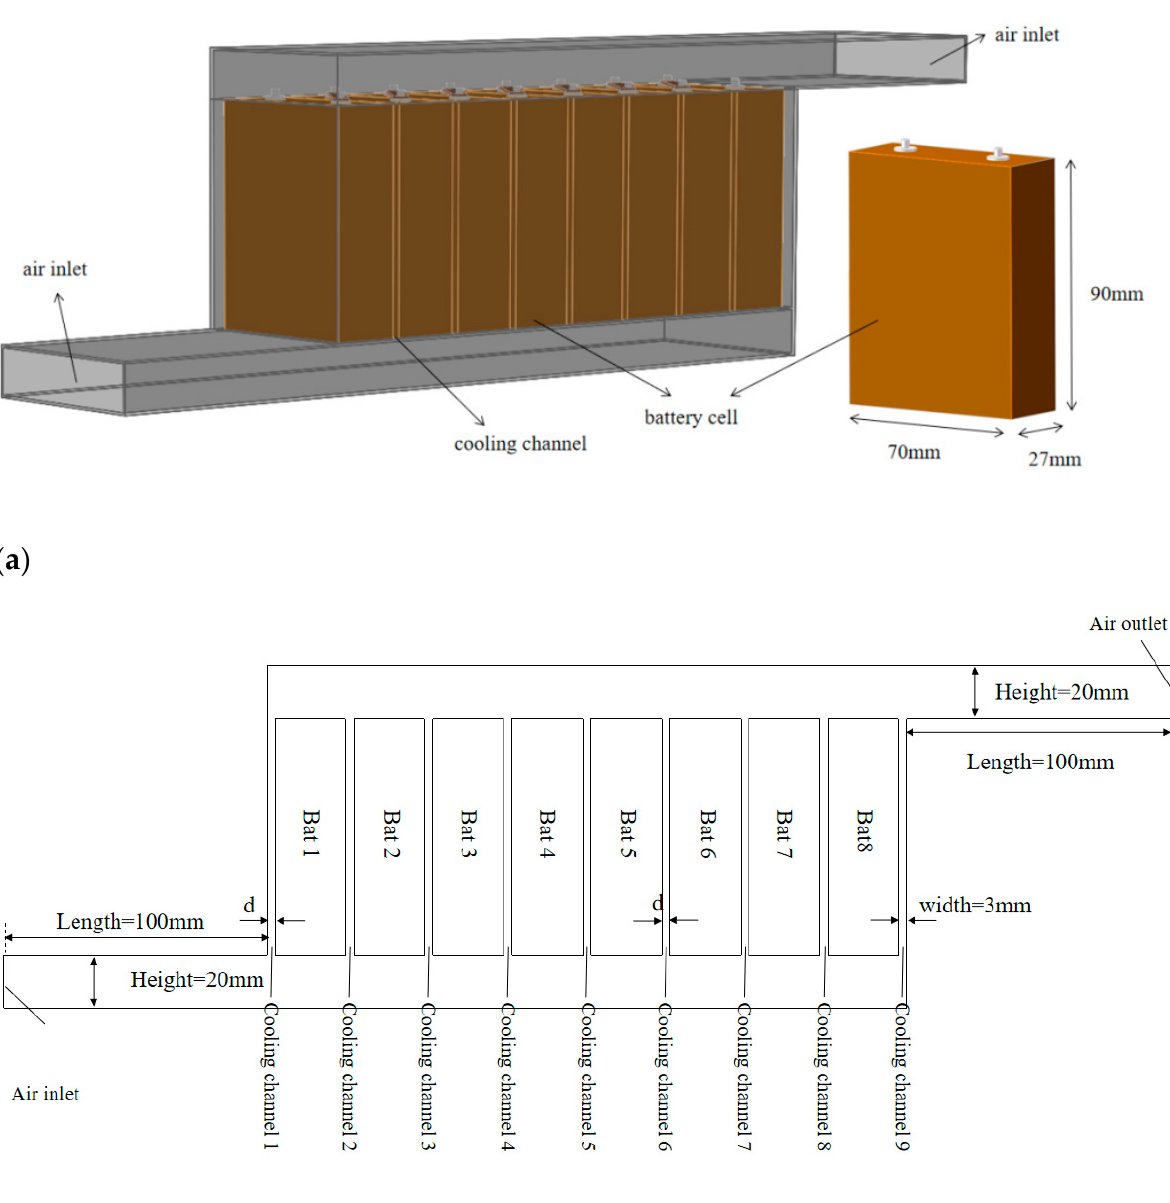
Figure 1. Diagram of the Z-type air-cooled battery thermal management system (BTMS); ( a ) 3D diagram of the Z-type air-cooled battery thermal management system (BTMS); ( b ) 2D diagram of the Z-type air-cooled battery thermal management system (BTMS).